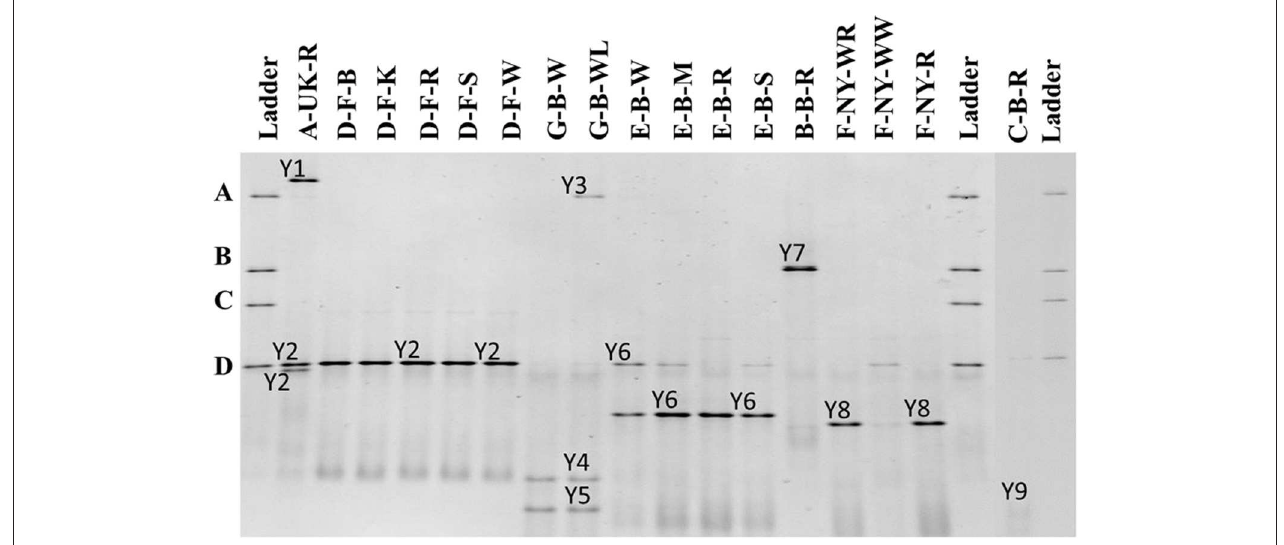
FIGURE 4 | Culture-independent 26S rRNA-PCR-DGGE community profiles of 17 sourdough samples from backslopped sourdoughs of different origins. The sample codes on top of each row are as described in Table 1 . The ladder was constructed using pure cultures of Wickerhamomyces anomalus DIV/07-076BY (A) , Kazachstania unispora DIV/07-125CR (B) , Candida glabrata DIV/07-076BZ (C) , and Saccharomyces cerevisiae DIV/07-125X (D) . The following yeast species were identified: Y1, Pichia myanmarensis (98% identity; accession no. KY108896.1); Y2, Saccharomyces cariocanus/paradoxus (100% identity; accession nos. KY109235.1/BR000309.1); Y3, Pi. myanmarensis (99% identity; accession no. KY108896.1); Y4, Dekkera bruxellensis (98% identity; accession no. AY969049.1); Y5, Dekkera anomala (99% identity; accession no. AY969114.1); Y6, Kazachstania exigua/pseudohumilis (100% identity; accession nos. NG_055049.1/KY106702.1); Y7, Kazachstania solicola (99% identity; accession no. KY107950.1); Y8, Kazachstania humilis (100% identity; accession no. KY106507.1); and Y9, Pichia fermentans (99% identity; accession no.